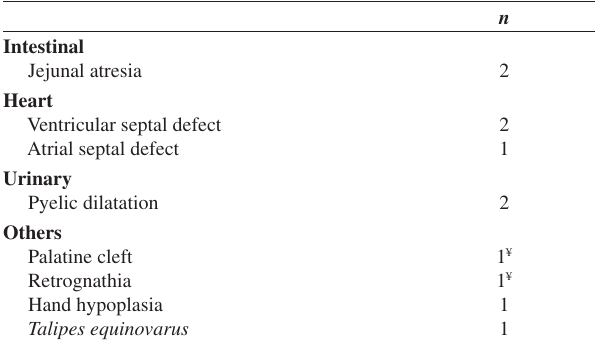
Table 1 - Congenital anomalies (nine